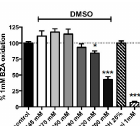
Figure 1. Influence of DMSO, ethanol, and semicarbazide on 1 mM benzylamine oxidation by human adipose tissue homogenates. Assays were performed at 37 ◦ C as described in Materials and Methods with hSCAT homogenates and 1 mM benzylamine as the control and the indicated final concentration of: DMSO: dimethyl sulfoxide; EtOH: ethanol; Semi: semicarbazide. The highest tested dose of DMSO (3700 mM) corresponds to its final concentration when used in pure form as a vehicle to solubilize a xanthine at 10 mM, then testing it at 2.5 mM final. The amount of H 2 O 2 generated during 30-min oxidation of benzylamine (1.40 ± 0.20 nmoles / mg protein / min) was set at 100% (dotted line), while baseline with only hScAT was set at 0 %. Mean ± SEM of n = 7–27 di ff erent individual preparations. Di ff erent from control at: * p < 0.05; *** p < 0.001 by one-way ANOVA